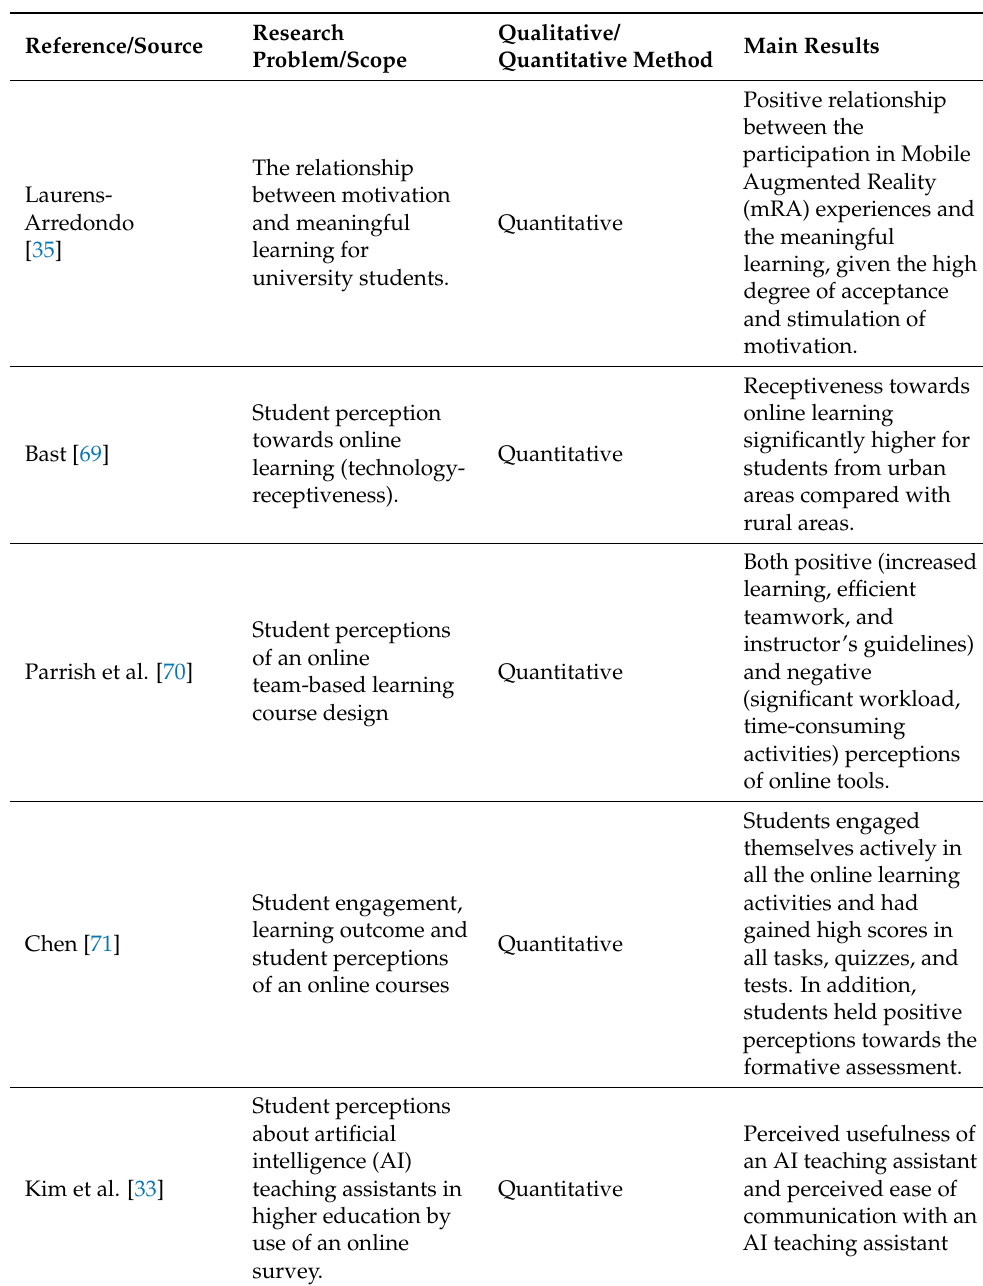
Table 3. Studies exploring the technology acceptance model